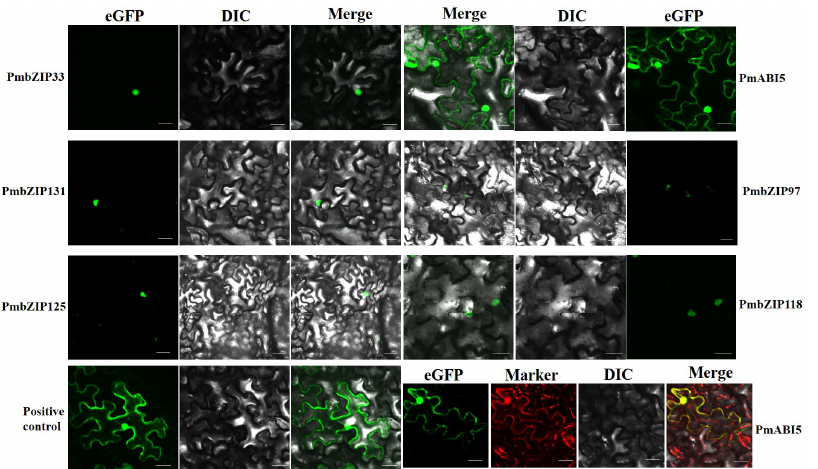
Figure 6. Subcellular localization of PmbZIPs. Marker was an endoplasmic reticulum (ER) marker protein; the positive control was pCAMBIA2300 ‐ eGFP. Red color indicates ER marker, green color indicates eGFP signal. Scale bars = 50 μ M.